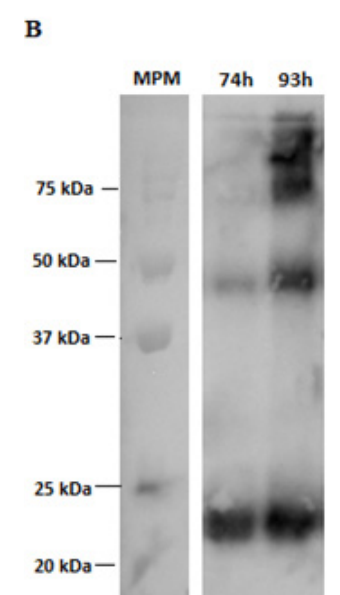
Figure 9. Western blotting labeled with anti ‐ RVM antibody from co ‐ infection assays (M MOI of 2 pfu/cell, G MOI of 3 pfu/cell). ( A ) 96 h post ‐ infection Schott flask samples. ( B ) Samples from 74 and 93 h post ‐ infection in the bioreactor. MPM = molecular weight marker.